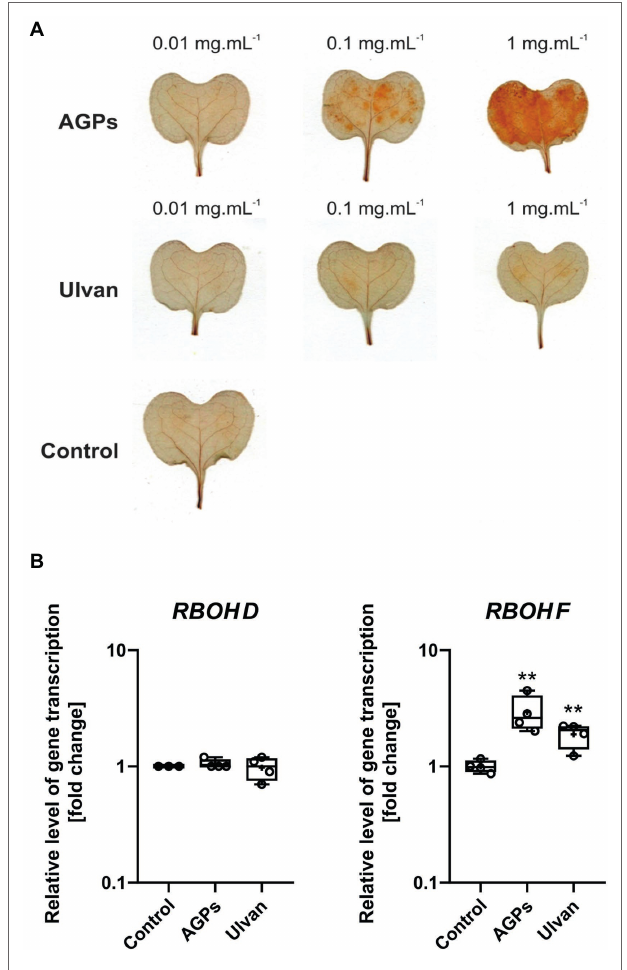
FIGURE 4 | Effect of algal elicitor treatment on accumulation of H 2 O 2 and expression of respiratory burst oxidase homologues ( RBOHs ) in B. napus cotyledons. Accumulation of H 2 O 2 in B. napus cotyledons (A) . Cotyledons (12-day-old) were treated with AGP-like enriched fraction (AGPs), ulvan extracted according to Yaich et al. (2013) (Ulvan), and distilled water (Control) by infiltration, the algal elicitors were tested in concentrations 0.01, 0.1, and 1 mg·ml − 1 . H 2 O 2 was detected 24 h after treatment using 3,3 ′ -diaminobenzidine, the presence of H 2 O 2 is represented by brown-red coloring. Expression of RBOHs in B. napus cotyledons (B) . Cotyledons were treated with AGP-like enriched fraction (AGPs), ulvan (Ulvan), and distilled water (Control) by infiltration in 0.1 mg·ml − 1 concentration. After 24 h, gene expressions of RBOH D and RBOH F were analyzed. Data from the representative experiment are shown. Relative expression was calculated with efficiency correction and normalization to actin . Data are plotted at the log 10 scale. Asterisks indicate statistically significant differences from control determined by the t -test ** p <